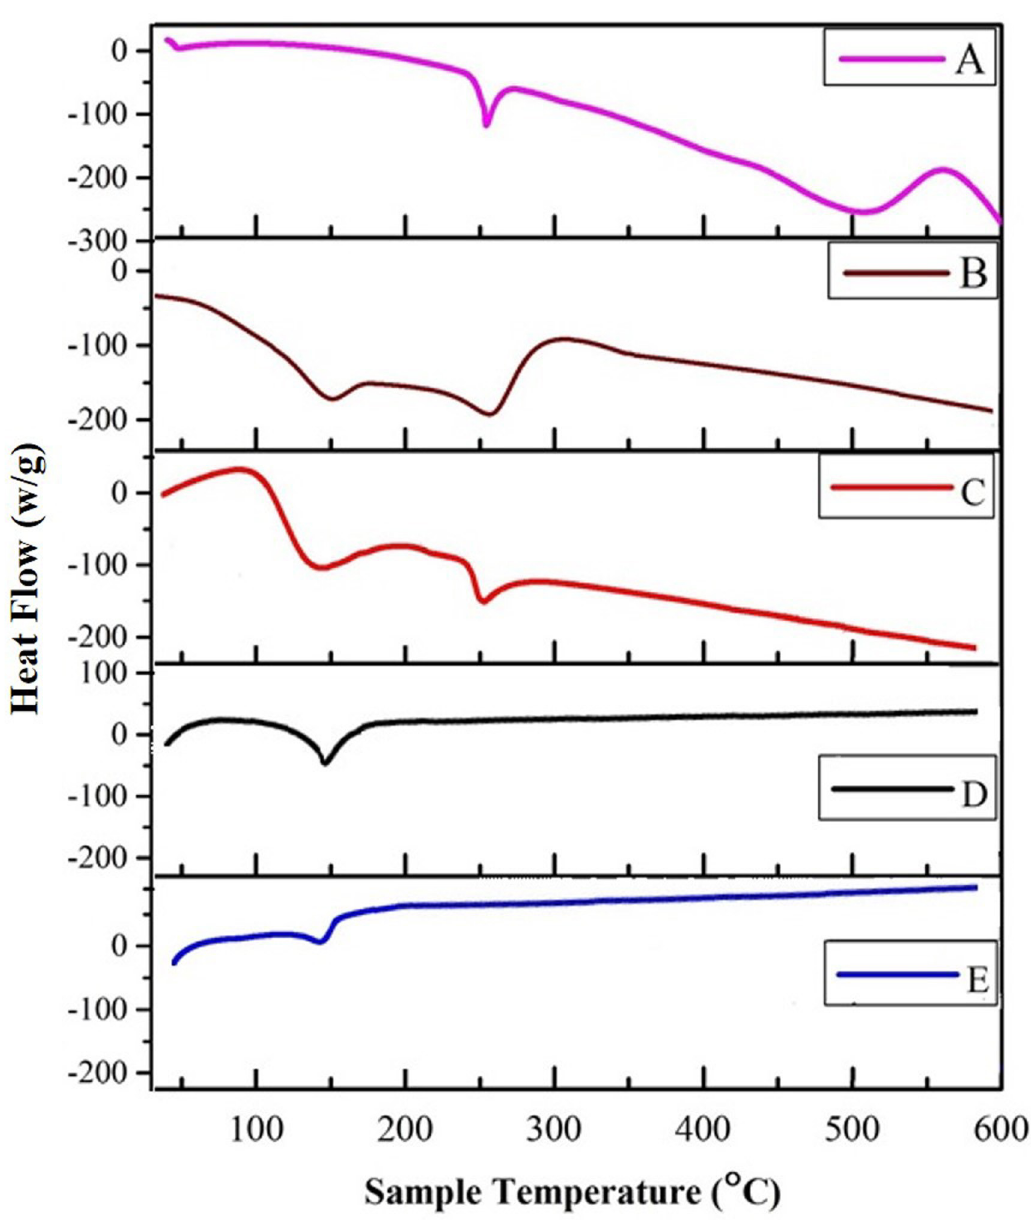
Fig 4. DSC of diacerein (A), egg lecithin based physical mixture (B), soy lecithin based physical mixture (C), D5PL (D) and D11PL (E).